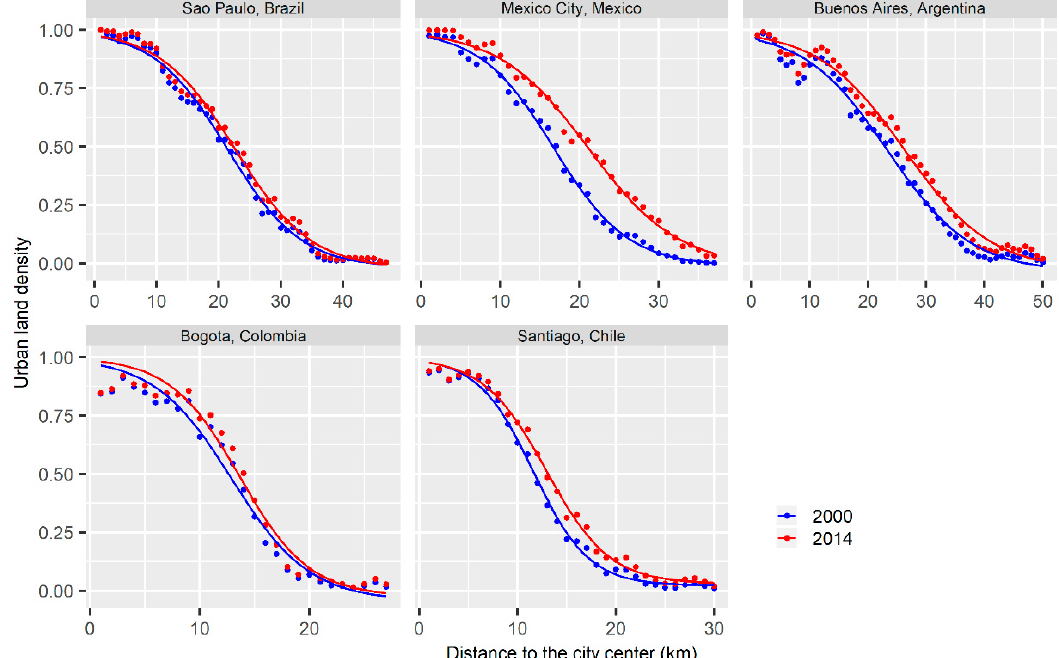
Figure 4. Distance decay of urban land density and fitted results using inverse S curve in concentric rings in five Latin American cities in 2000 and 2014. Table 2. Parameters of the inverse S curve for five Latin American cities in 2000 and 2014.